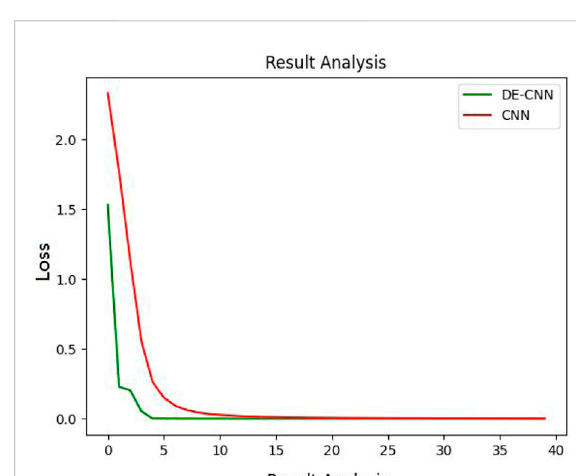
FIGURE 8 Loss changes with the evolutionary algebra.